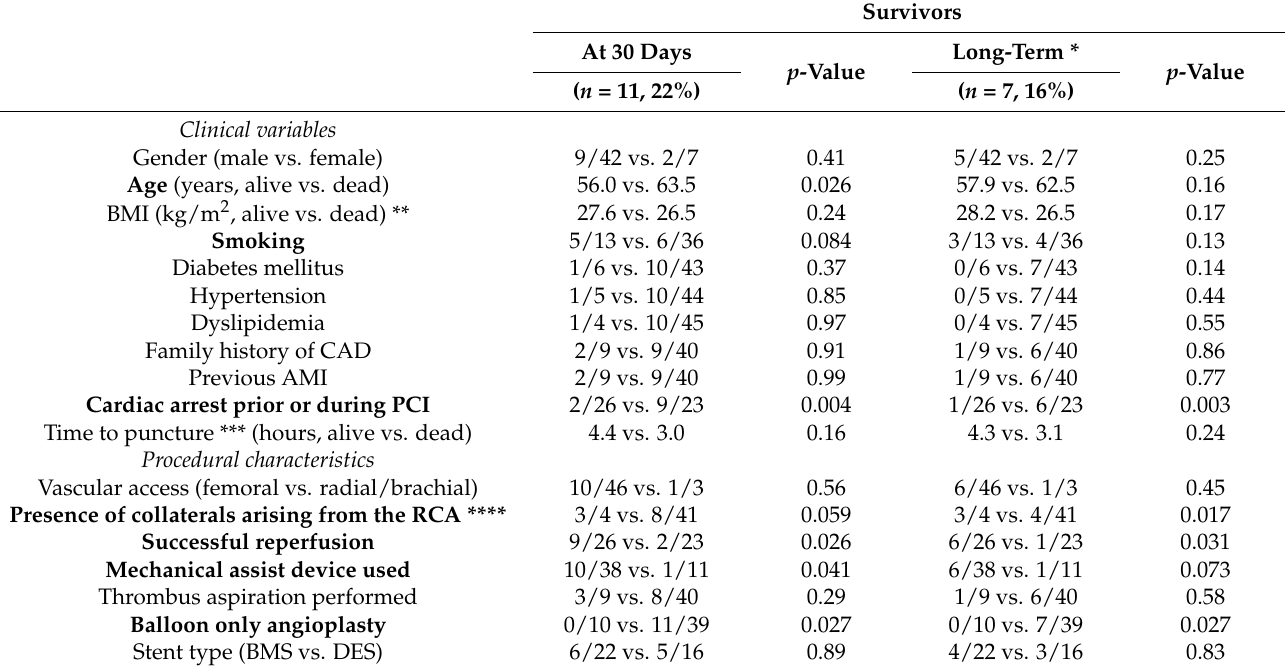
Table 4. Univariate